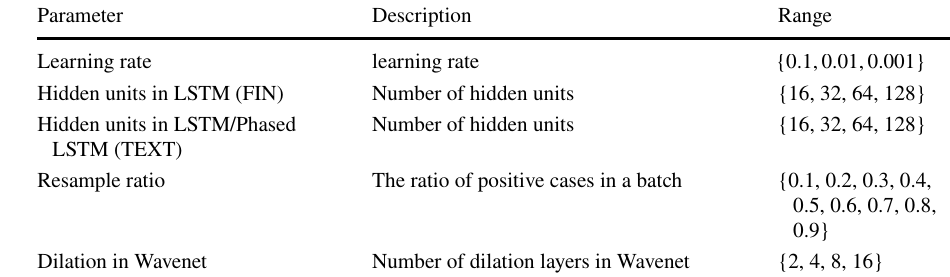
Table 3 Comparison of different methods. Note that each method was trained 5 times and we report their average performance and standard deviations (in brackets) for comparison